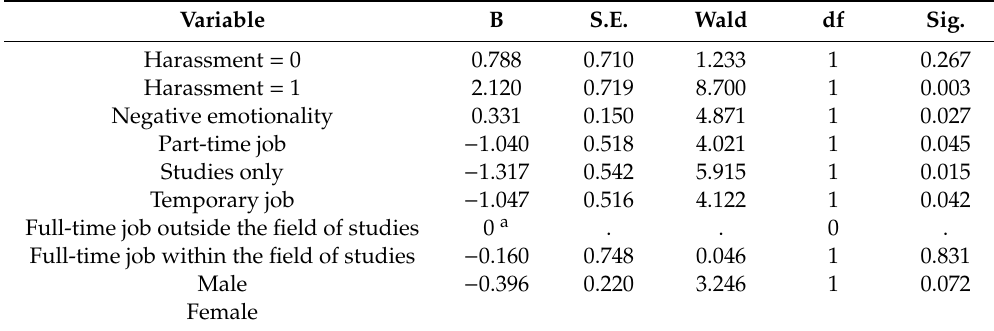
Table 10. Streamlined Model 5—Harassment: ordinal logistic